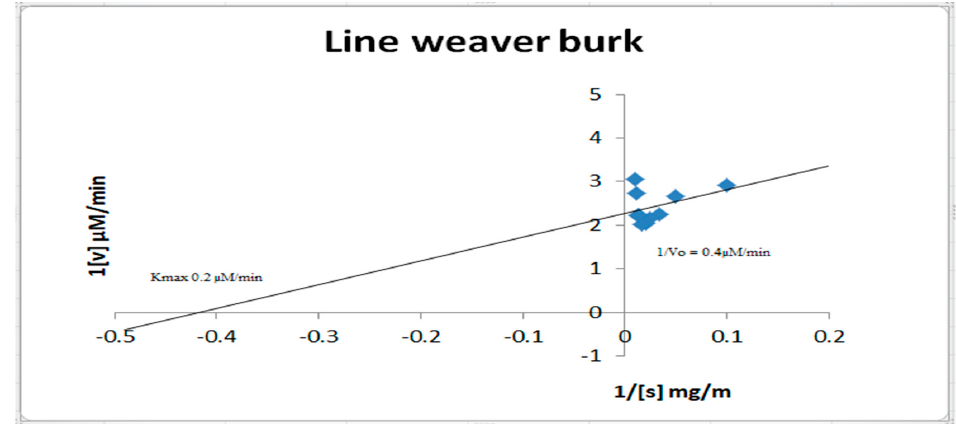
Figure 9. Inhibition kinetics of urease activity.